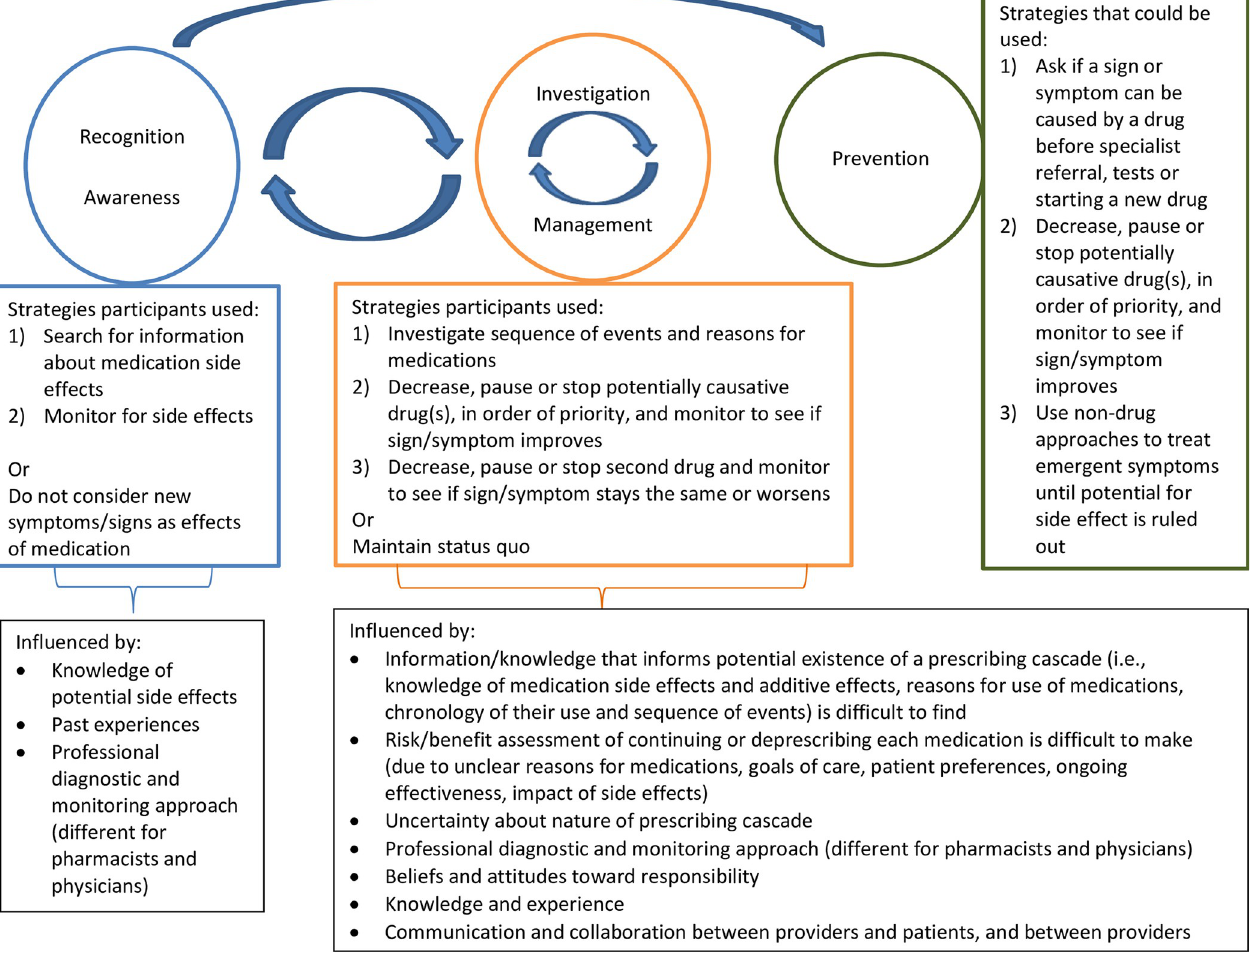
Fig 2. Themes related to recognition, investigation, management and prevention of prescribing